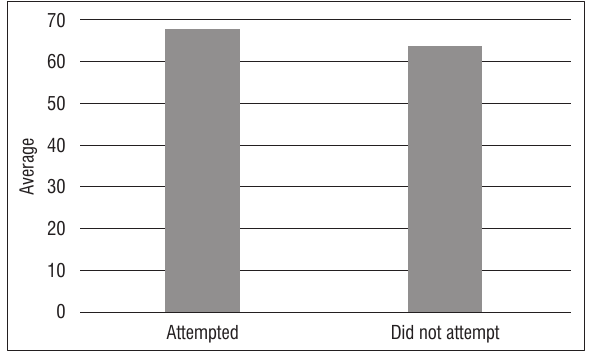
Figure 5: Average final exam percentages for Math150 students who attempted and completed the quiz and those who did